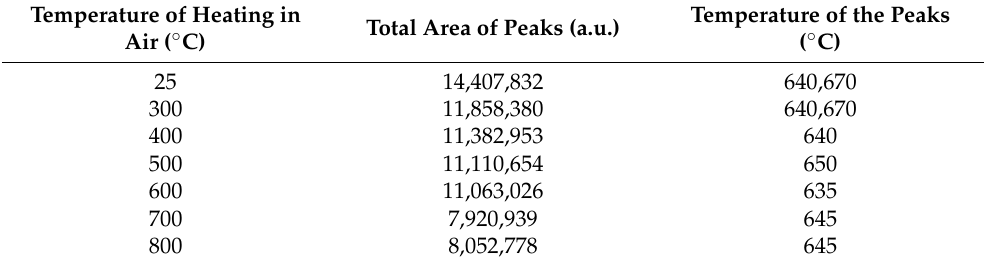
Table 4. Results of the study of 10% V/ γ -Al 2 O 3 catalyst using H 2 -TPR. Temperature of Heating in